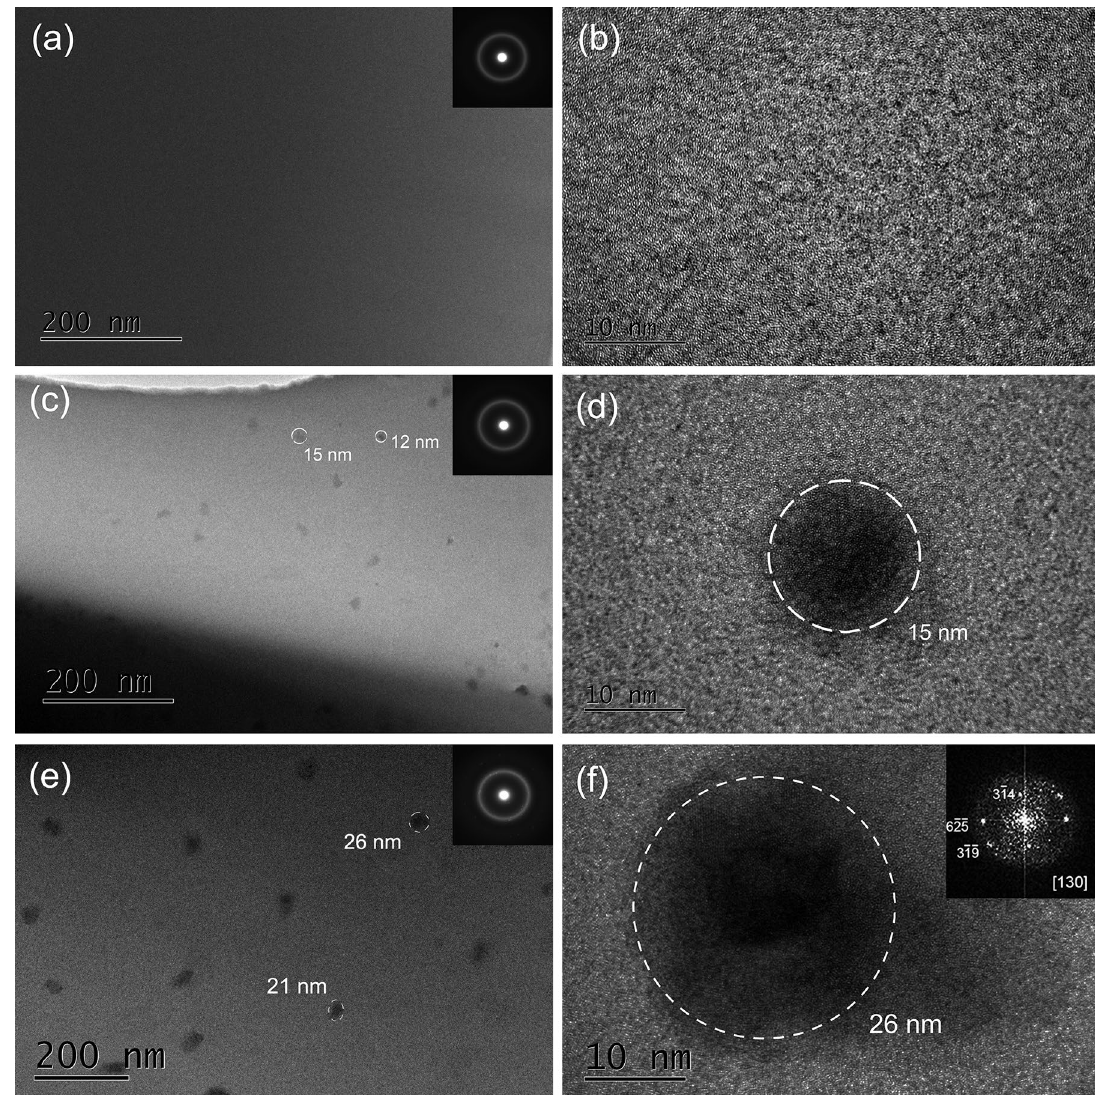
Zr Al ) Y Nb alloys treated at conditions: (a, b) untreated; 47 45 8 97.5 1.5